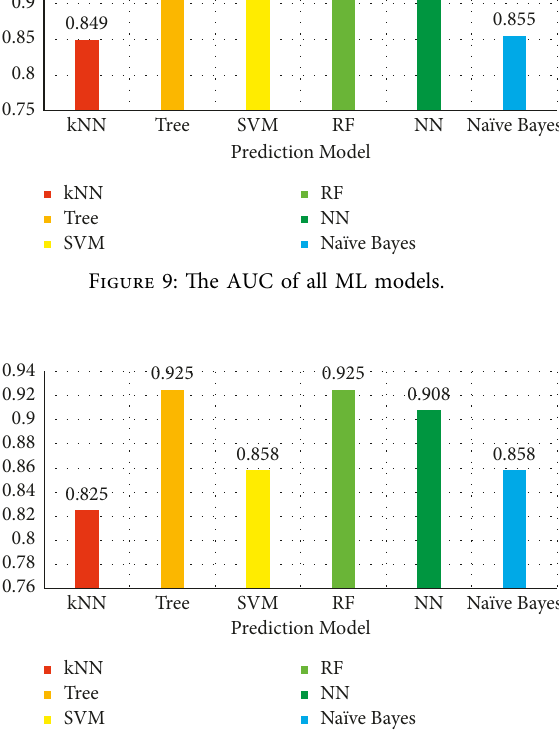
Figure 10: The CA of all ML models.